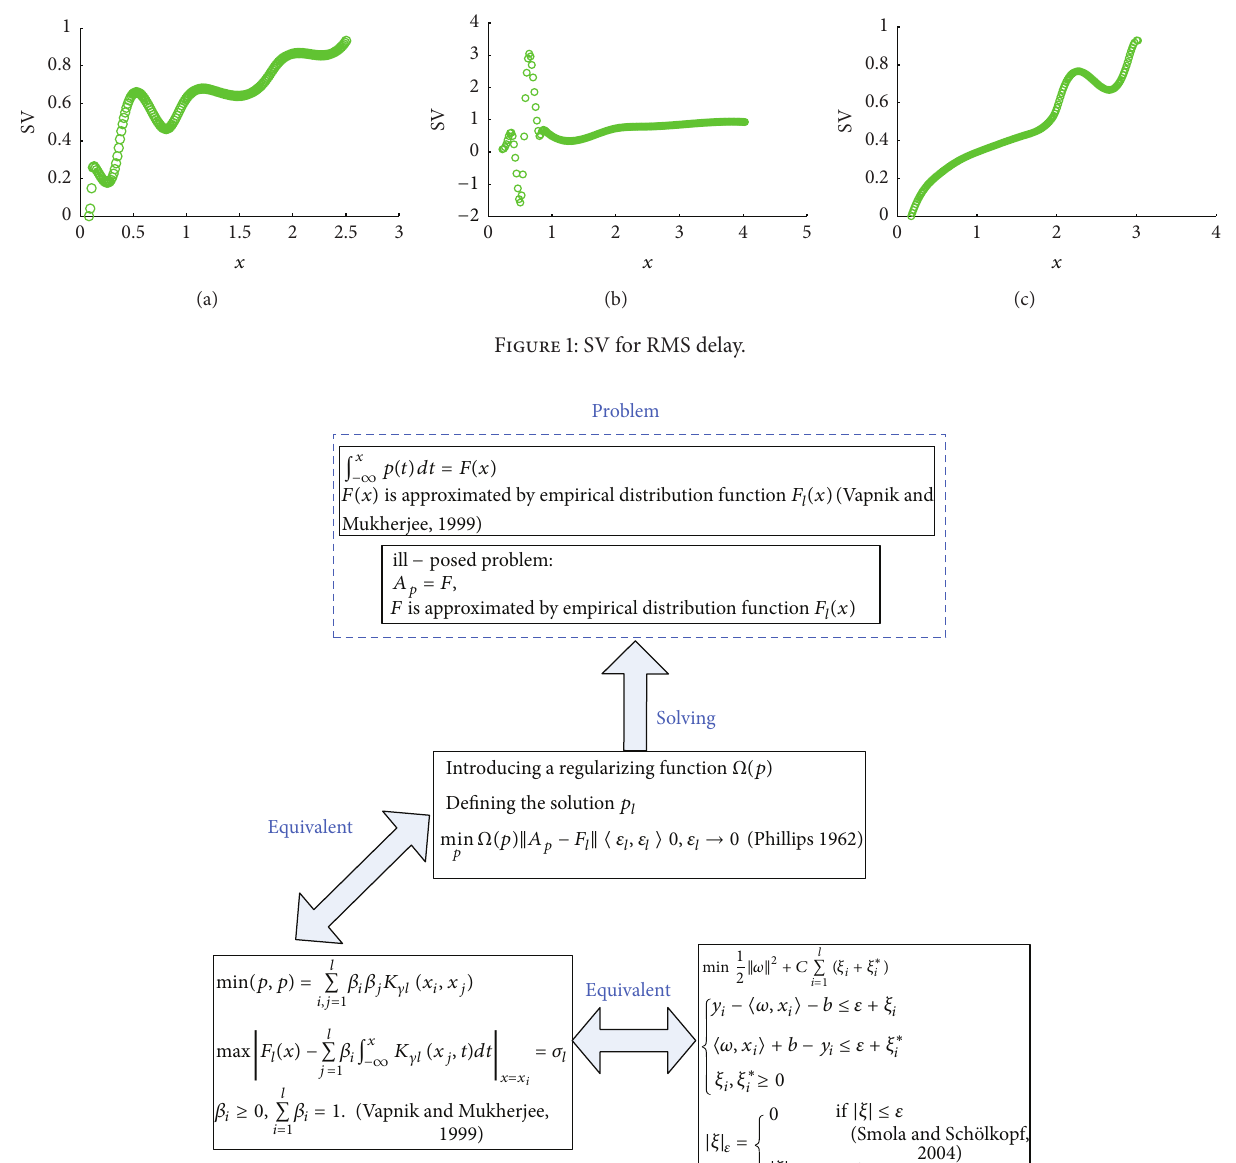
Figure 1: SV for RMS delay.